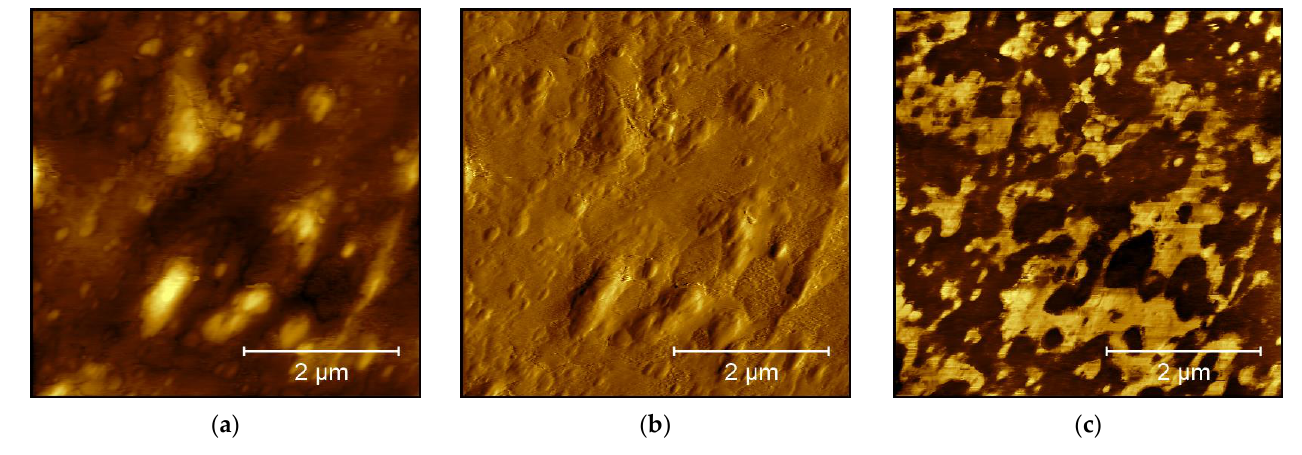
Figure 11. AFM images of a 3D printed Z3D surface: ( a ) topography (height range 174 nm); ( b ) amplitude; ( c ) phase image (phase range 77°).